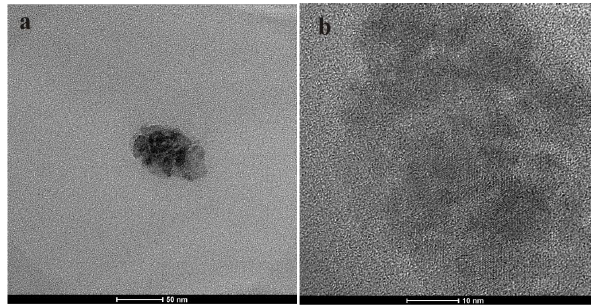
Figure 6. Panel (a) shows the TEM image and (b) HRTEM image of an O-, Si-, S-, and Cu-containing particle aggregation obtained from an ascending gas flow above the soil over the Dongshengmiao deposit.